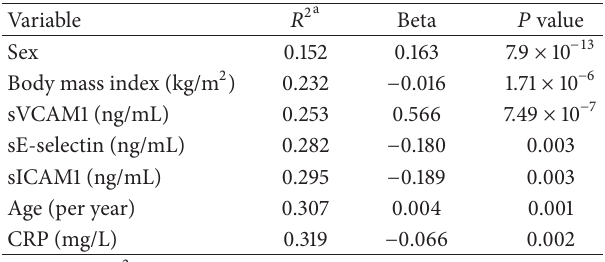
Table 3: Adiponectin levels: stepwise linear regression analysis. Variable 𝑅 2